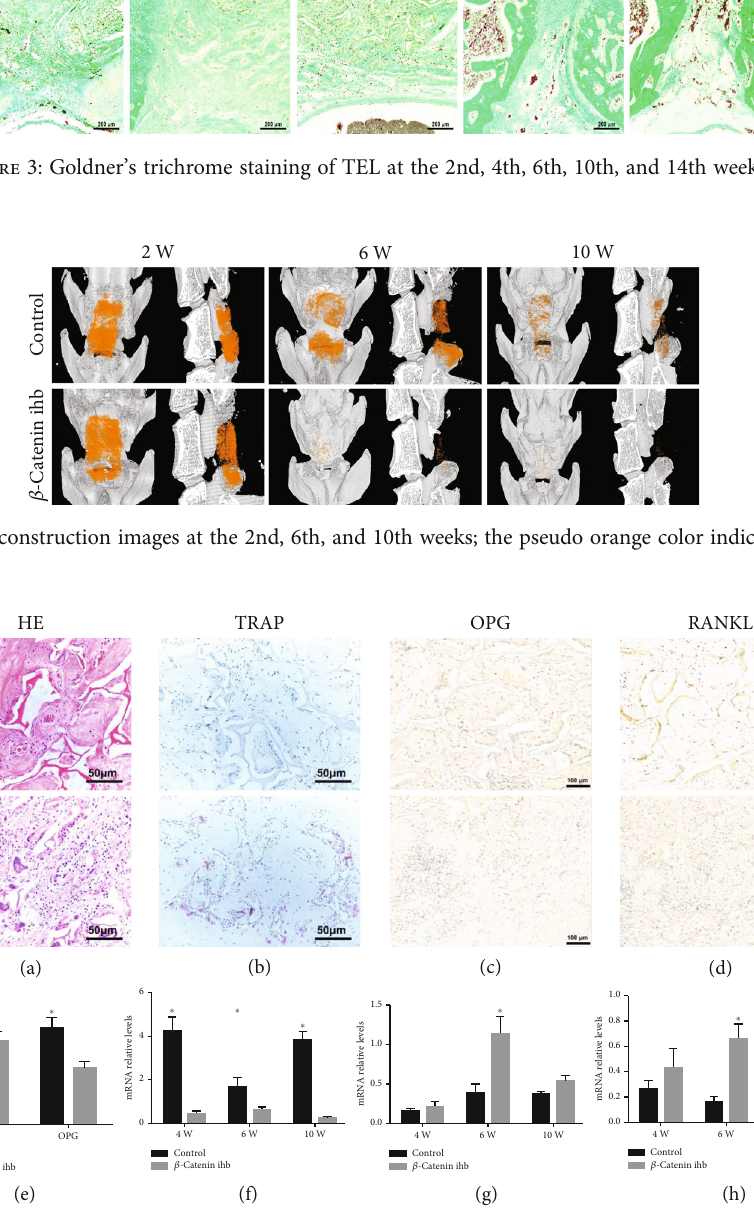
Figure 5: (a) HE staining of the newborn laminae at the 10th week; (b) TRAP staining of the newborn laminae at the 10th week; IHC staining of (c) OPG and (d) RANKL at the 10th week; (e) percentage of positive staining of RANKL and OPG at the 10th week; mRNA expression levels of (f) OPG, (g) RANKL, and (h) CTSK. ∗ P < 0 : 05 (control vs. β -catenin inhibition group at the same time